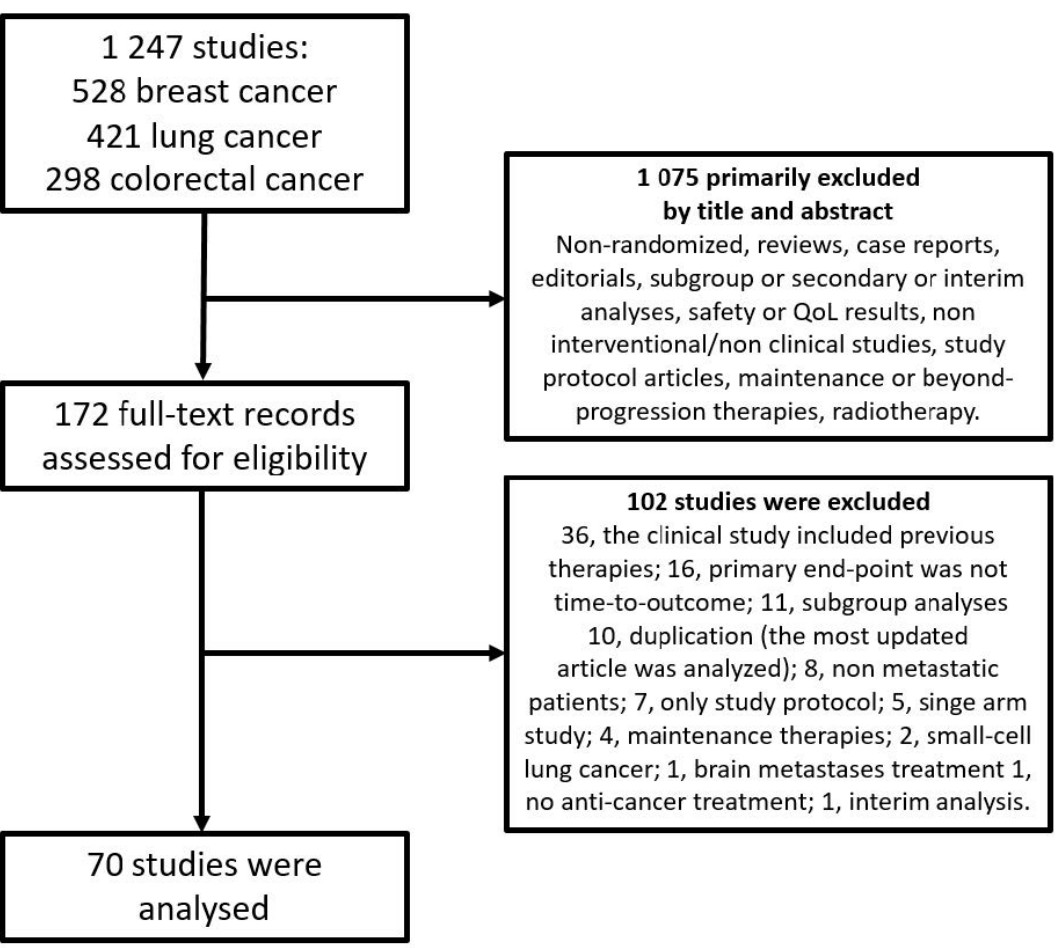
Figure 1. Studies selection flow-chart.